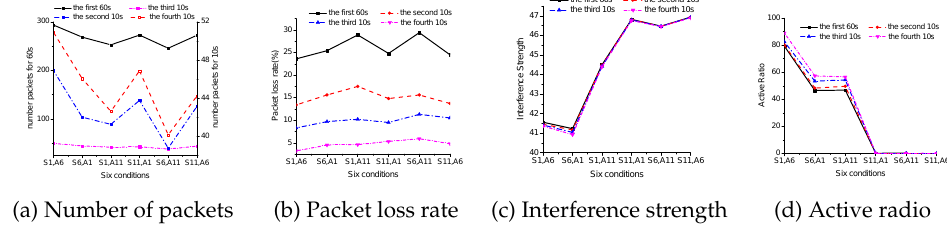
Figure 8. Four parameters to characterize the duration of channel interference between the safe wireless transmitter and the other normal public APs under six